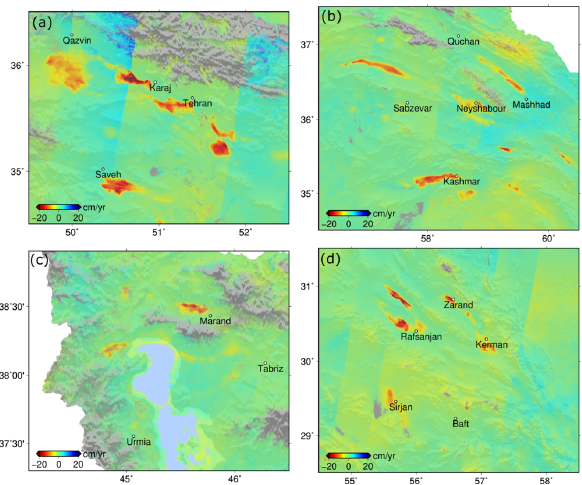
Figure 4. close up views of subsidence areas indicated by dashed lines in Figure 3 irrigated area (Figure 4-b). Mashhad, the second most